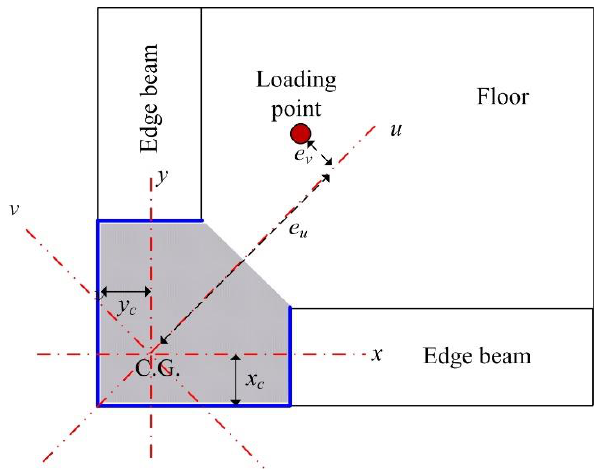
Figure 15. Nonsymmetrical composite column and loading position.